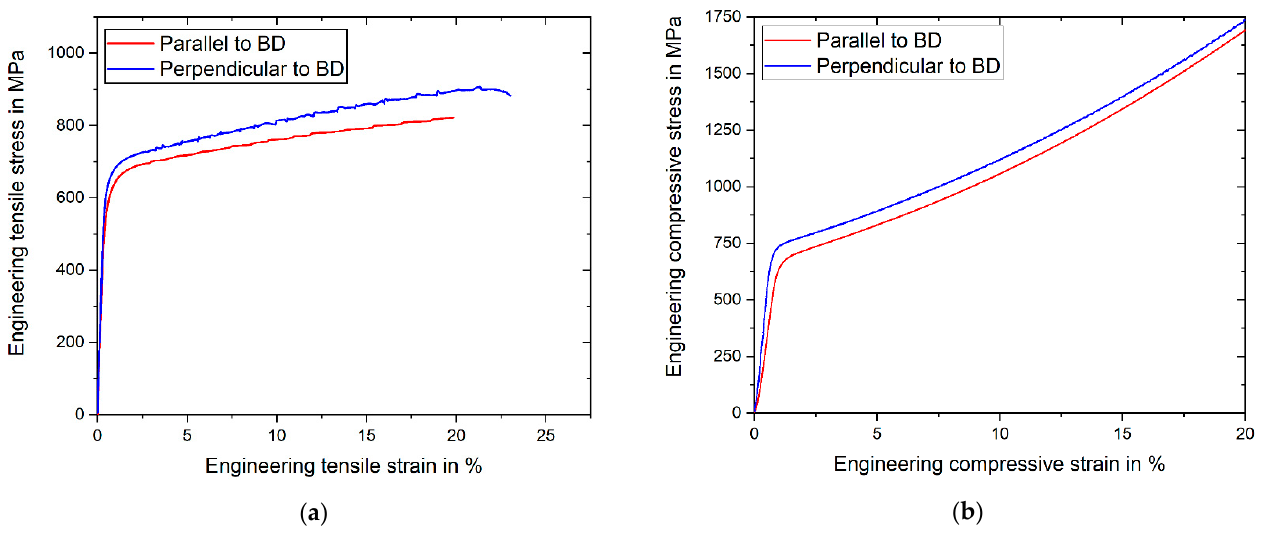
Figure 4. Representative tensile ( a ) and compressive ( b ) engineering stress-strain curves for specimens oriented with their longitudinal axis parallel and perpendicular to BD. Table 2. Mechanical properties of LPBF samples oriented parallel or perpendicular to build direction